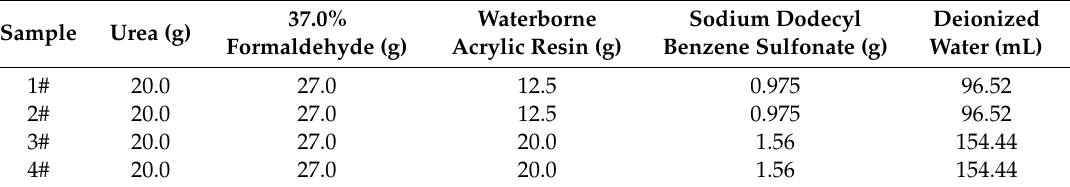
Table 2. The amount of substance in the orthogonal